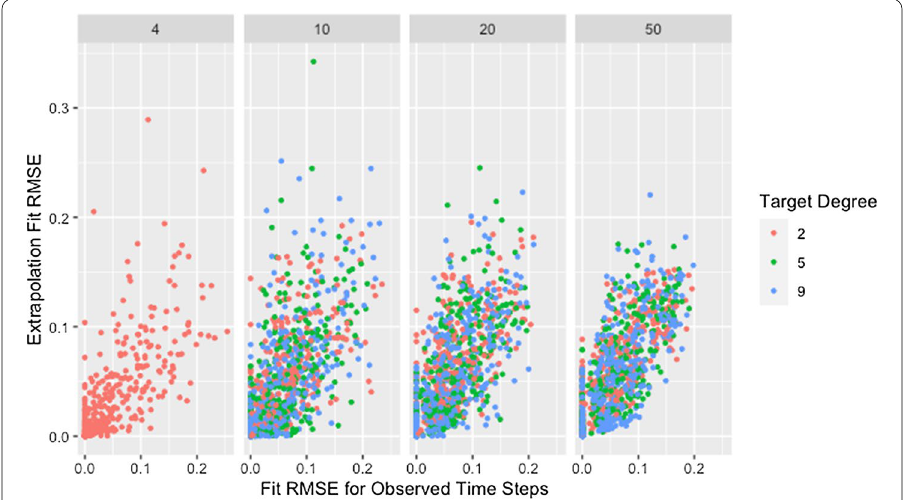
Fig. 14 Extrapolation RMSE by fit RMSE, degree, and size. RMSE for observed and predicted opinions on extrapolated time steps by RMSE for observed and predicted opinions on observed time steps, target degree, and network size across